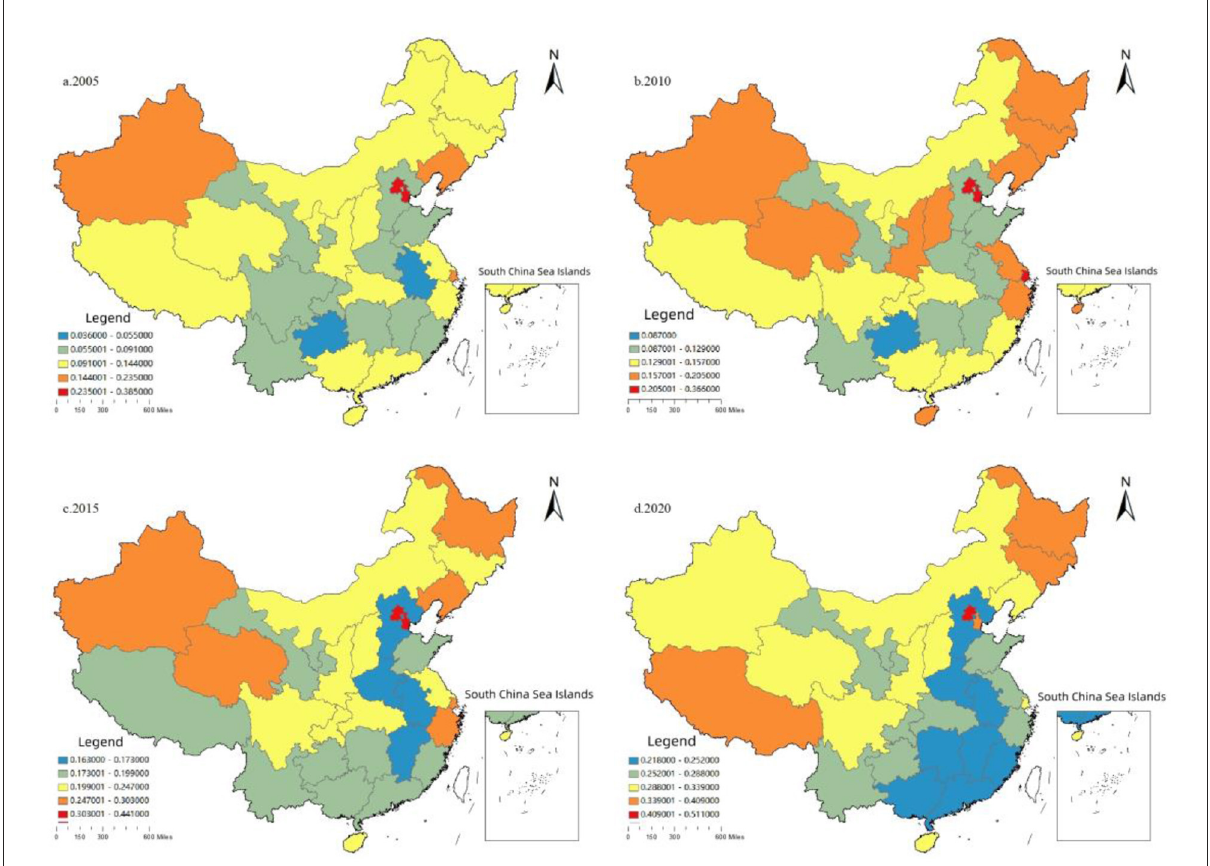
FIGURE4 The spatial distribution of the MHSS level in